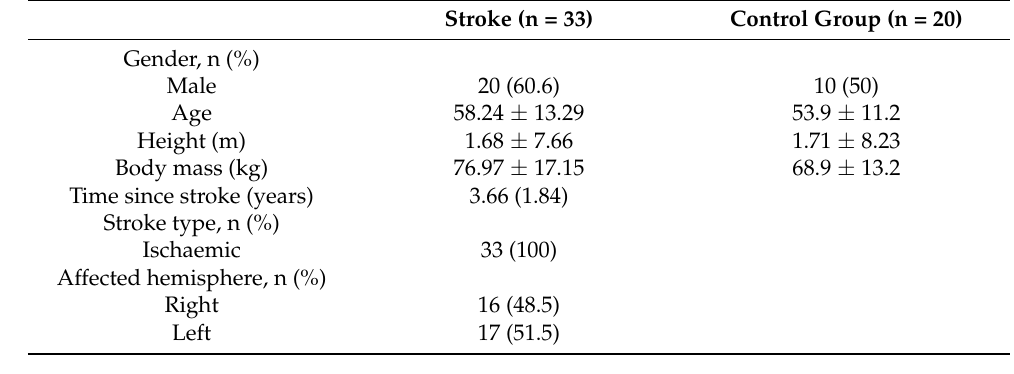
Table 1. Participants’